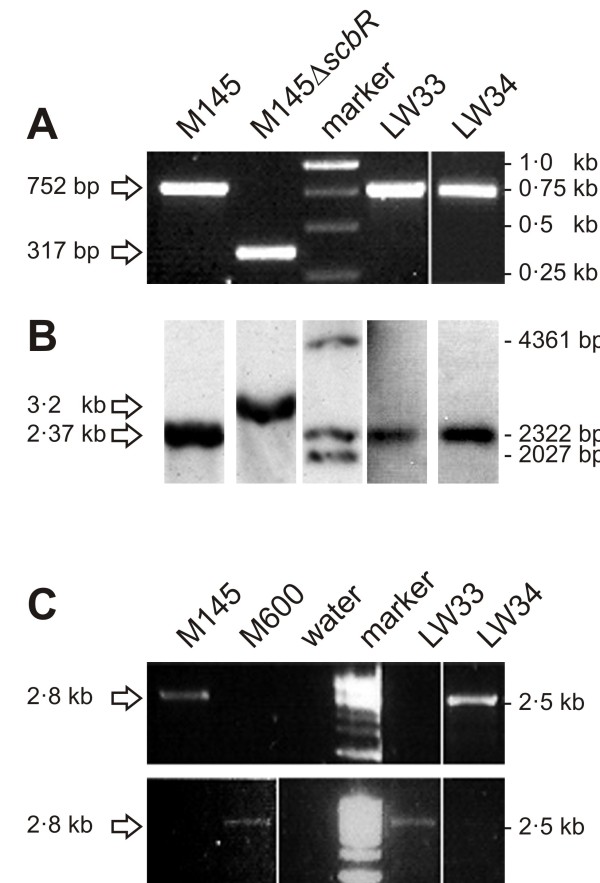
 Verification of full-lengthscbRM145/M600inS. coelicolorstrains LW34 and LW33. A. PCR was carried out using primers ETseq3 and ETS7 to amplify a 752 bp full-length scbRM145/M600 fragment and a 317 bp fragment from the ΔscbR region. The 317 bp PCR product was only found with the LW33/LW34 parental M145ΔscbR mutant. A full-length scbRM145/M600fragment was amplified from a wt control (M145) and from LW33 and LW34. Obtained PCR products are indicated with arrows on the left; sizes of the marker bands are given on the right. The M145-/M600-type of the gene was confirmed by DNA sequence analysis (data not shown). B. Southern analysis was carried out using NcoI digested genomic DNA of the four strains. A DIG-labelled DNA probe was used to detect the expected 3.2 kb fragment with M145ΔscbR and 2.37 kb fragments with the wt control (M145) and LW33 and LW34. Detected DNA fragments are indicated with arrows on the left; sizes of the marker bands are given on the right. C. PCR was carried out using primers RCseq31 and scbR-M145_c358 (scbR-M600_c358a) to amplify a 2.8 kb scbRM145 (scbRM600)fragment. The latter are specific for the base change between the two scbR variants. A scbRM145 fragment was only obtained with control strain M145 and with LW34, whereas control strain M600 and LW33 showed a scbRM600 specific PCR product. Using water as template did not give any product. Obtained PCR products are labelled with arrows on the left; a 2.5 kb marker band is indicated on the right.